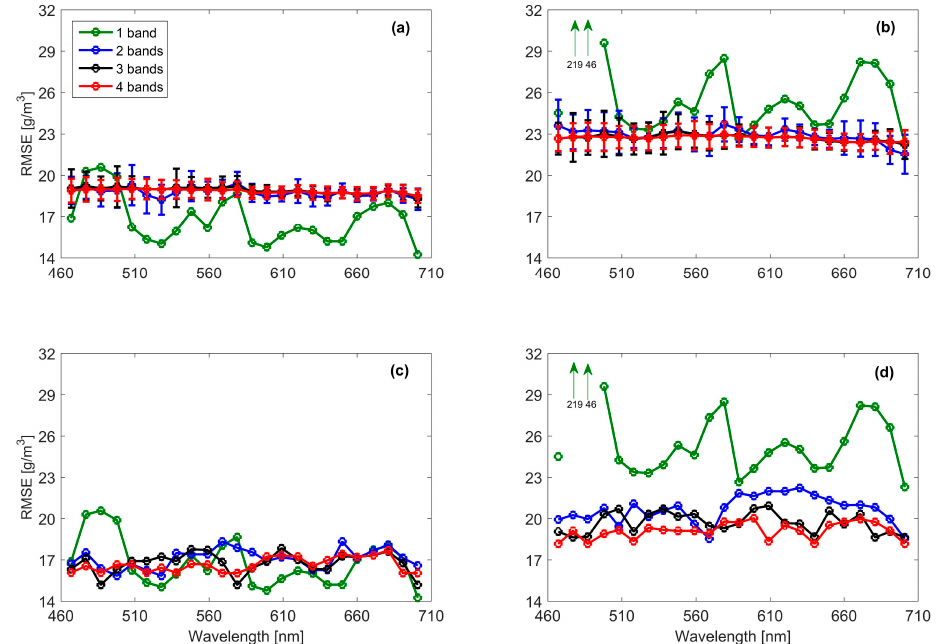
Figure 7. Root-mean-square error (RMSE) obtained from calibration left ( a , c ) and validation right ( b , d ) of the inversion of the radiative transfer model (Equation (8)) using different number of Hyperion bands combinations: mean and one standard deviation, which is denoted as error bar ( a , b ), and minimum ( c , d ), computed at a spectral band using all the possible pairs of that spectral band with the others. Out of range data (indicate complete model failure) are represented with an arrow and the corresponding RMSE values are reported next to it.